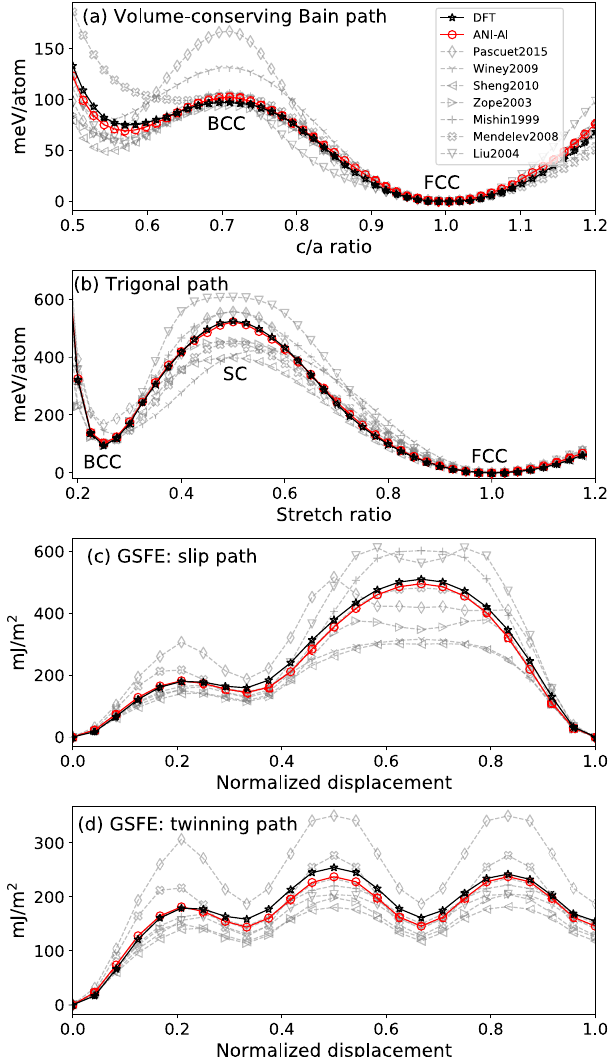
Fig. 2 Transformational energy barriers. We compare ANI-Al and various classical potentials to reference DFT data. a Volume-conserving Bain path energies. b Trigonal path energies. c Generalized stacking fault energy (GSFE) slip path. d GSFE twinning